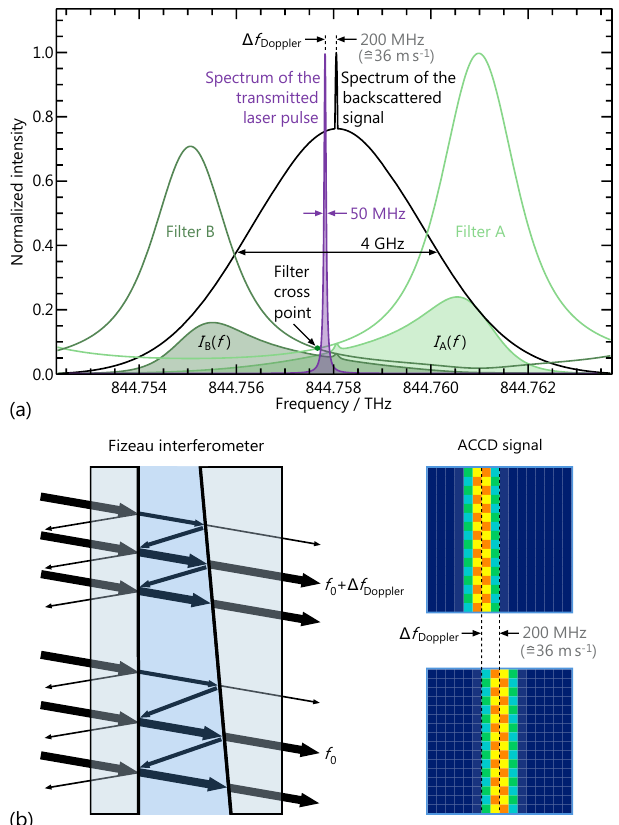
Figure 2. (a) Spectral distribution of the transmitted laser pulse (purple) and the backscattered signal (black), which is composed of the narrowband Mie and the broadband Rayleigh component. The transmission spectra of the two FPI filters of the Rayleigh channel are shown in green, while the filled areas illustrate the respective intensities I A (f ) and I B (f ) transmitted through the filters A and B for determining the Doppler shift. (b) Operation principle of the Mie channel based on the fringe-imaging